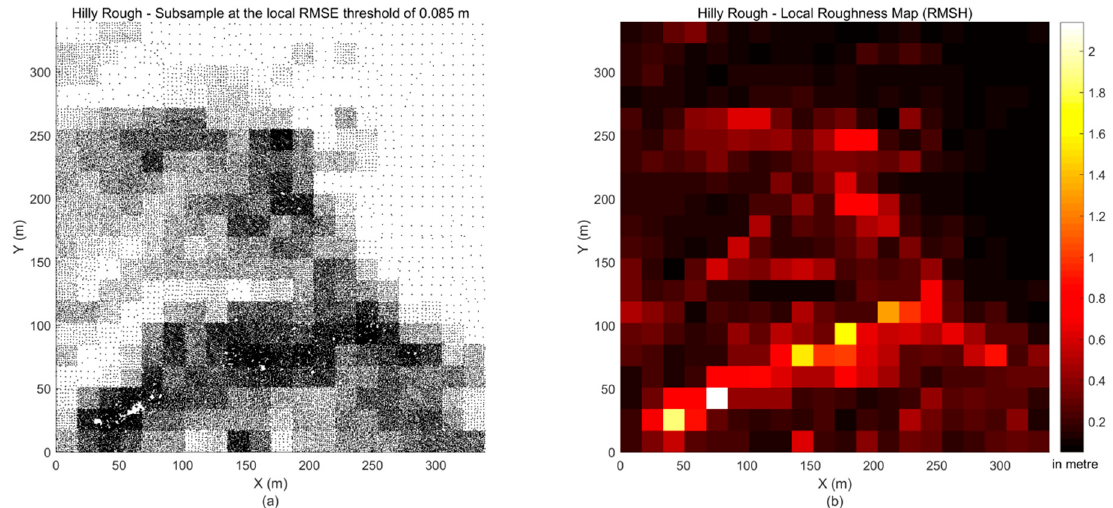
Figure 4. The hilly rough terrain surface: ( a ) the sub-sampled point cloud obtained using the coarse-to-fine method (20 × 20 = 400 sub-areas, the threshold RMSE = 0.085 m), ( b ) the local surface roughness root mean square height (RMSH).